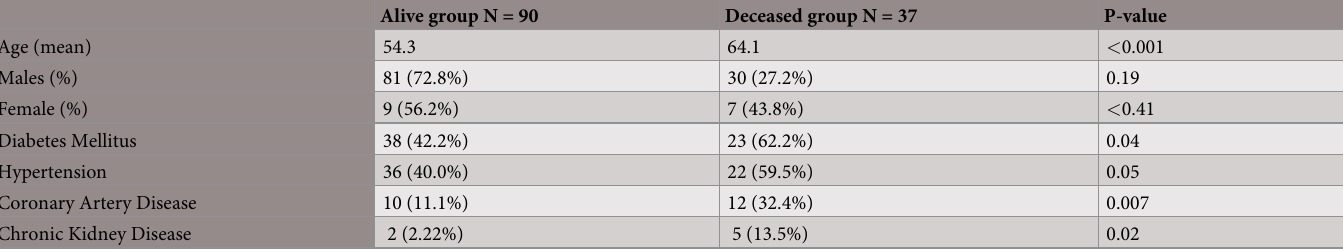
Table 2. Clinical